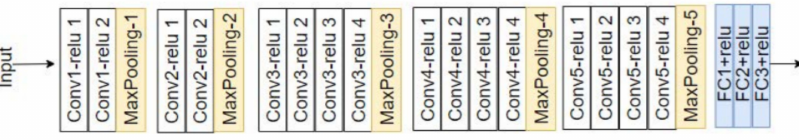
Figure 14. VGG 19 network architecture